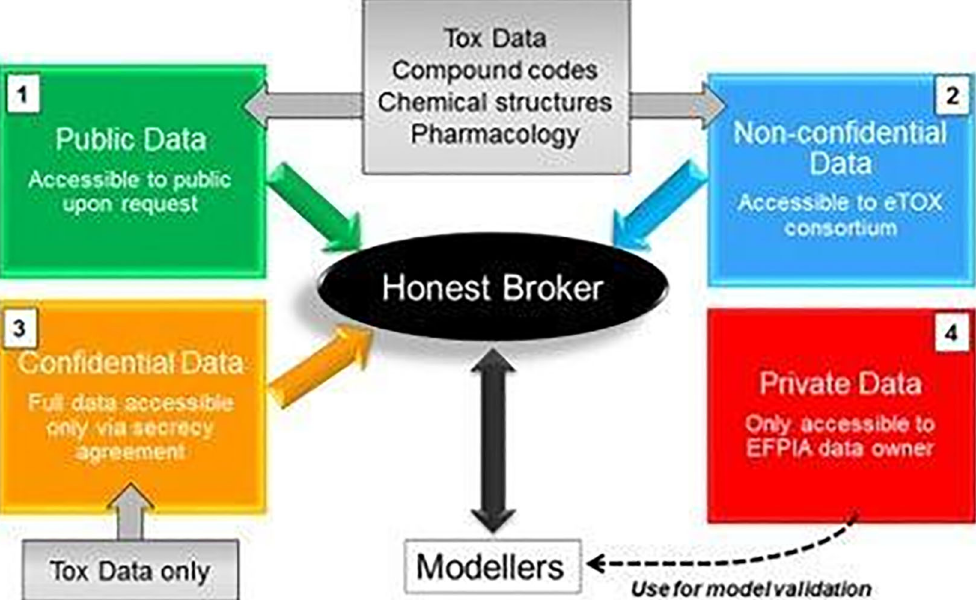
Figure 1. Data components, and roles of data processor. Precompetitive data shared within the eTRANSAFE Consortiumareclassifiedintopublicdata,non-confidentialdata,confidentialdata,andprivatedata.Shareddataare shuttled across participatory partners and managed by the Honest Broker who facilitates data access and exchange across the data processors in different